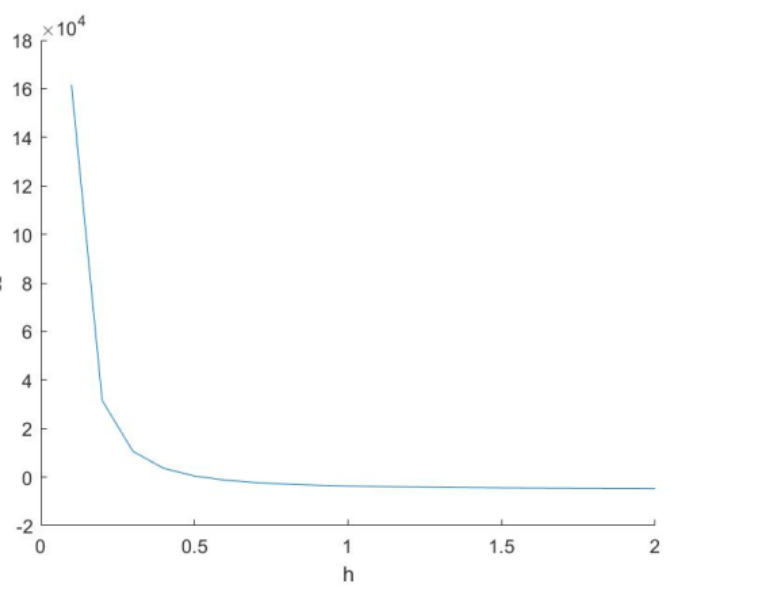
Figure 5. The effect of h on Π ∗ ( p ∗ , q ∗ ) . Note: U 0 = 100, t 1 = 100, t 2 = 20, l = 600, β = 0.1, C a = 5000, Λ = 200, p = 1, τ = 1 .